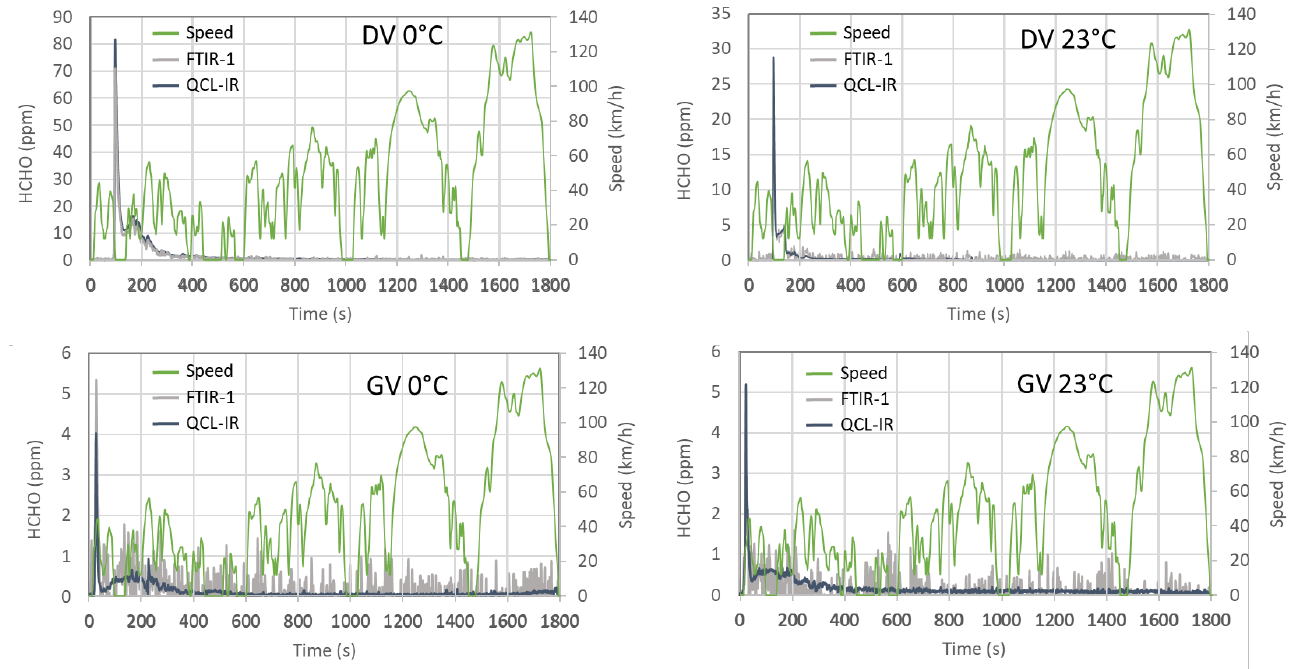
Figure 2. HCHO emission profiles of the DV and GV during the WLTC at 23 and 0 °C. N.B., the concentrations of HCHO from the DV at 23 and 0 °C (top panels) are represented using two different scales.